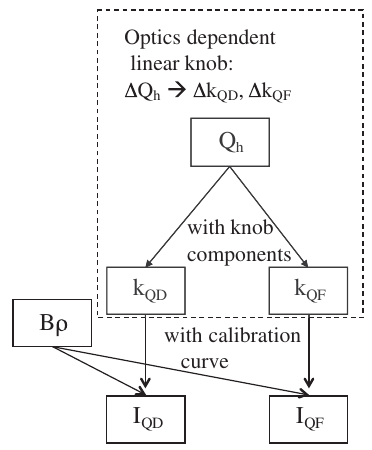
FIG. 14. Illustration of parameter tree for simple example of linear Q h knob. The parameter relations are stored in the database as well as the settings. So-called “ makerules ” are invoked when parent parameters are modified and all dependent parameters are automaticallycalculatedfollowingtheserules.Which “ makerules ” to use is stored with the parameter relations in the